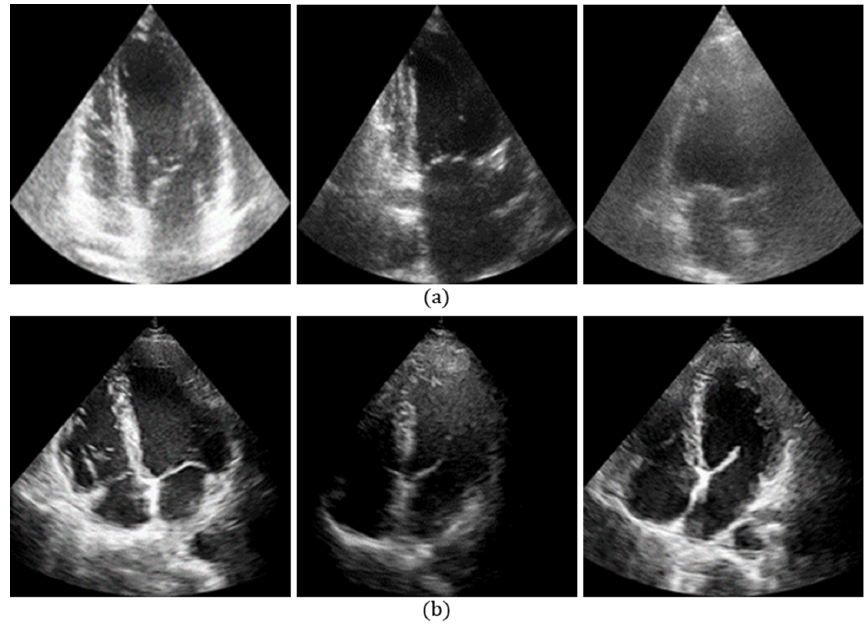
Figure 1. Echocardiography samples from different medical centers and vendors ( a ) CAMUS dataset: GE Vivid E95 ultrasound scanners with a GE M5 S probe and ( b ) self-acquired dataset: Vinno G86 ultrasound scanners with a S1–6 PX probe.